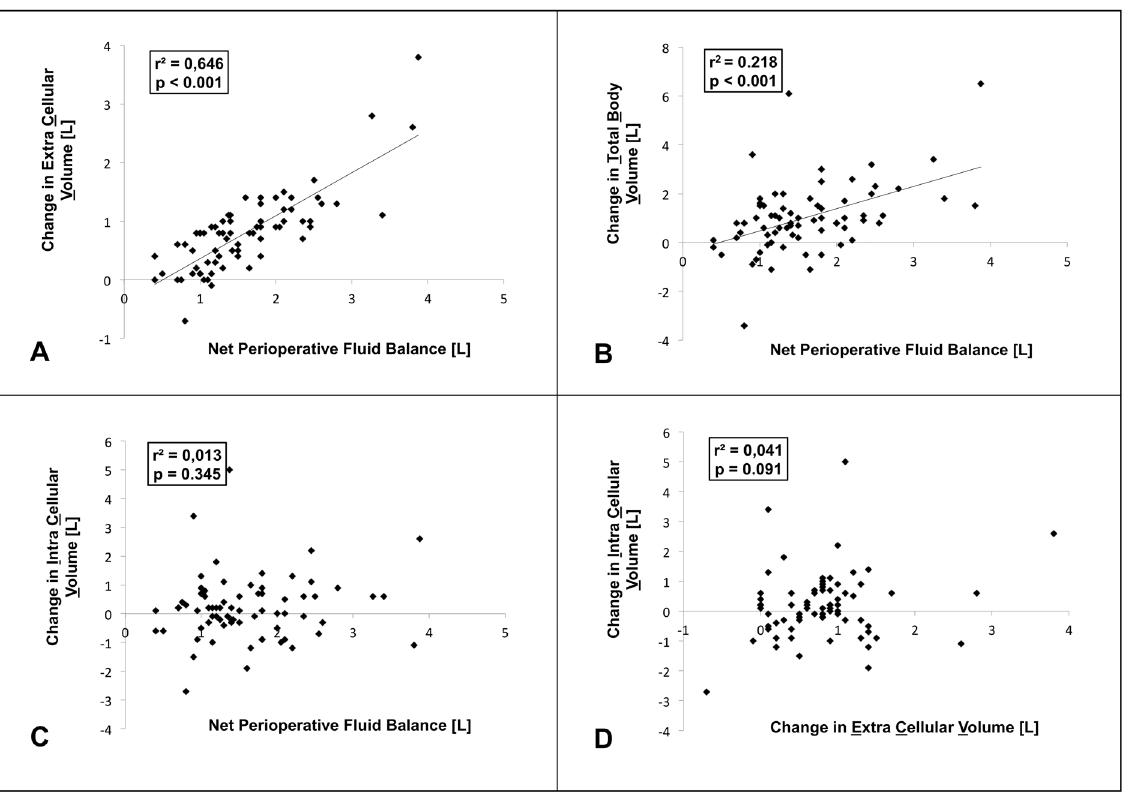
Figure 1. Associations between pre- to postoperative changes in volume status and net perioperative fluid balance. Scatter plots. Regression equations are as follows: A Change in Extracellular Volume=0.73 6 Net Perioperative Fluid Balance –0.37. B Change in Total Body volume=0.91 6 Net Perioperative Fluid Balance –0.43. C No linear correlation between Change in Intracellular Volume and Net Perioperative Fluid Balance. D No linear correlation between Change in Intracellular Volume and Change in Extracellular Volume. Pearson correlation test. R 2 =Coefficient of determination.